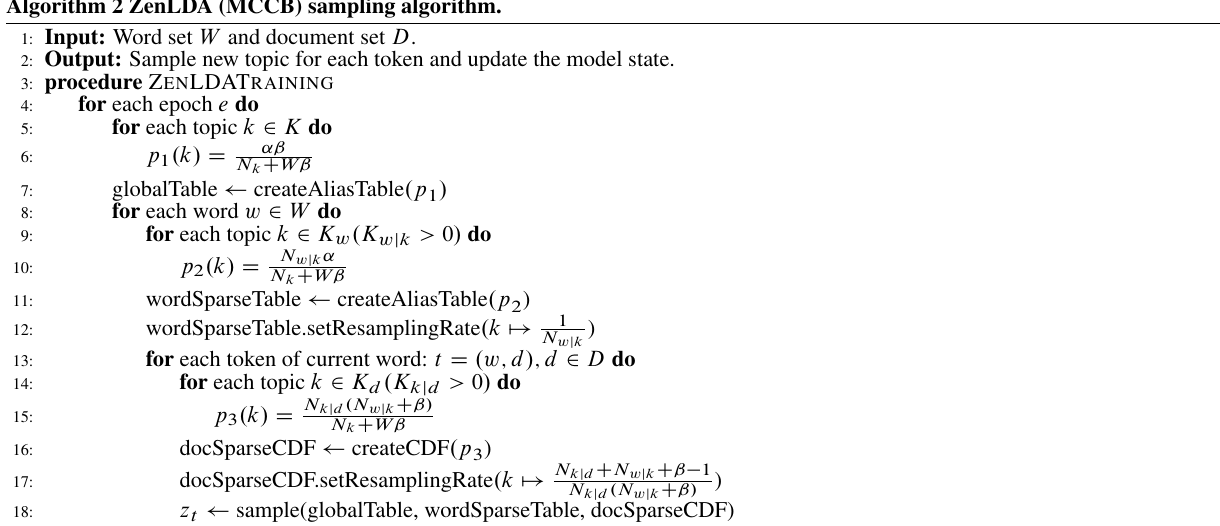
Algorithm 2 ZenLDA (MCCB) sampling algorithm.